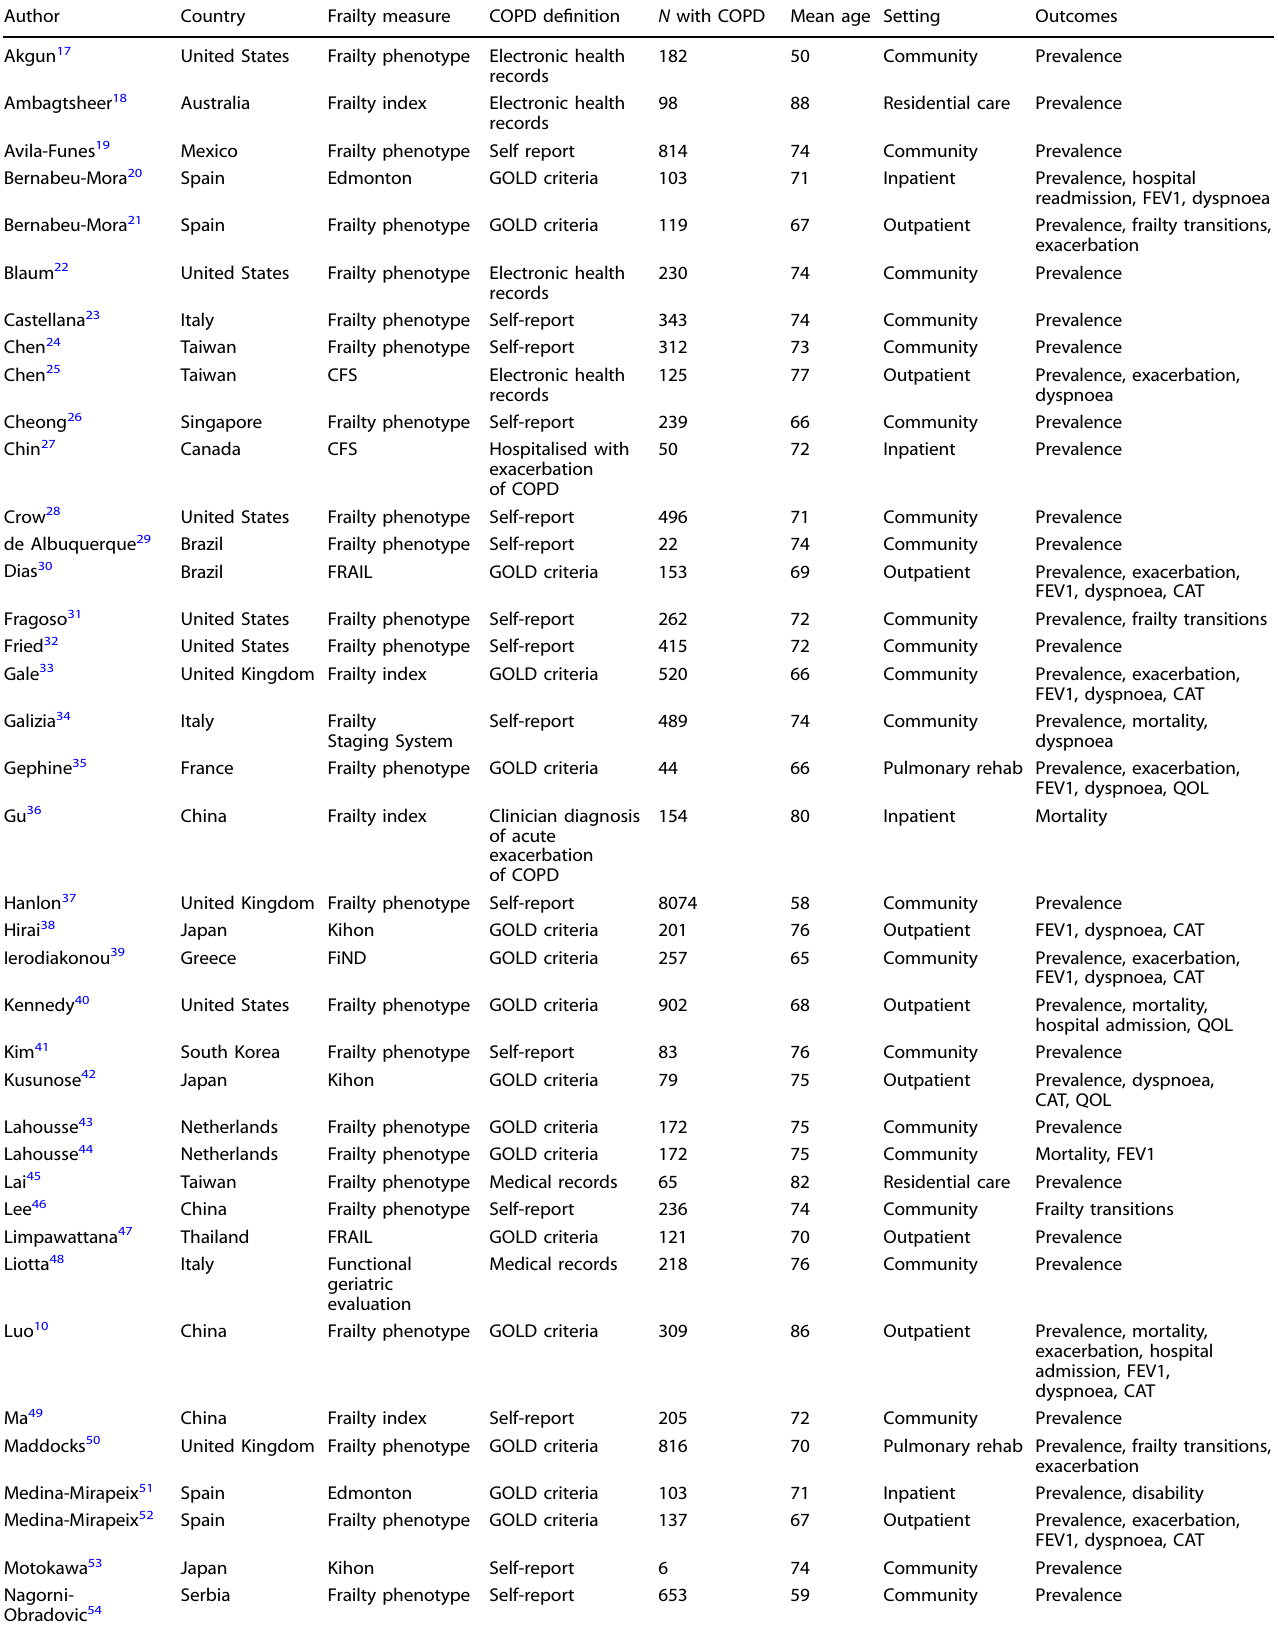
Table 1. Study characteristics and quality